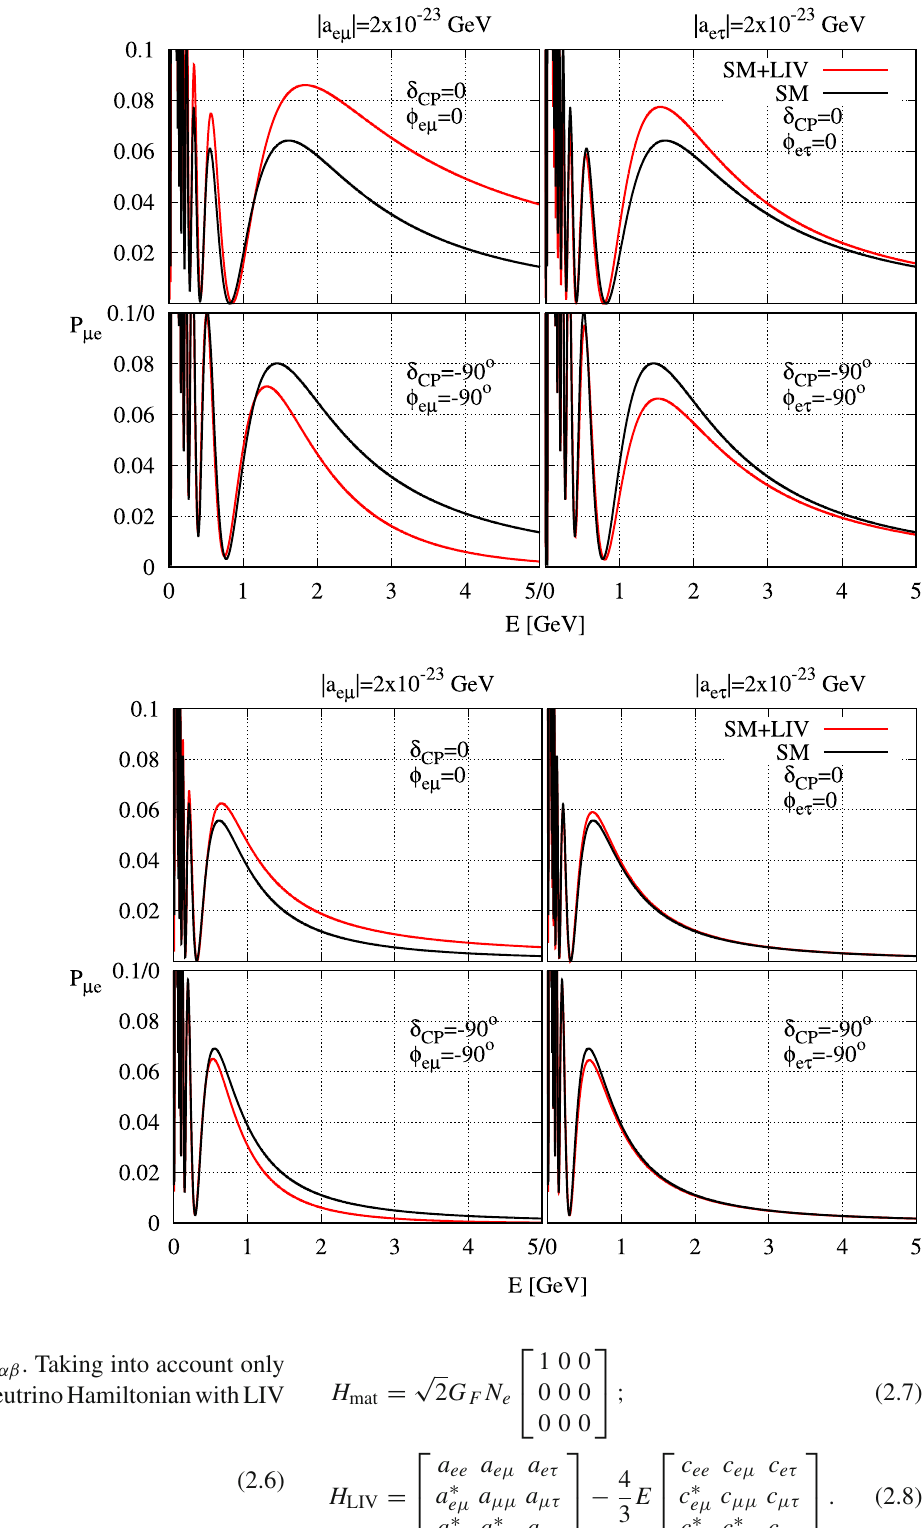
Fig. 1 Effect of | a | ( | a | ) = 2 × 10 − 23 GeV e μ e τ on the oscillation probability for NH of NO ν A in the left (right panel). The black line shows the oscillation probability with standard matter effect. The standard oscillation parameter values have been fixed to their best-fit values [7,8]. The red line indicates the oscillation probability with LIV effect. Values of δ CP , φ e μ and φ e τ have been mentioned in the panels